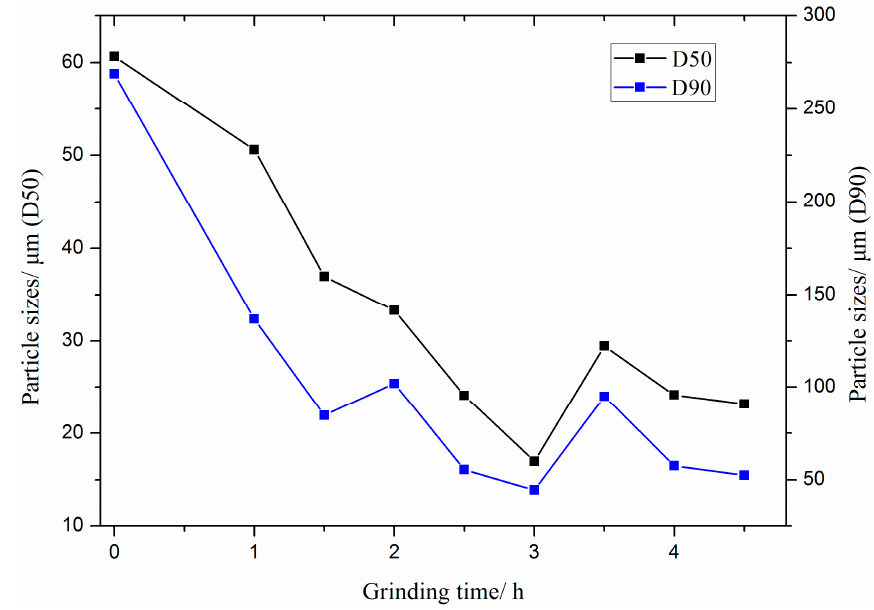
Figure 6. Variations of particle sizes (D50 and D90) of copper-mine tailings after grinding.